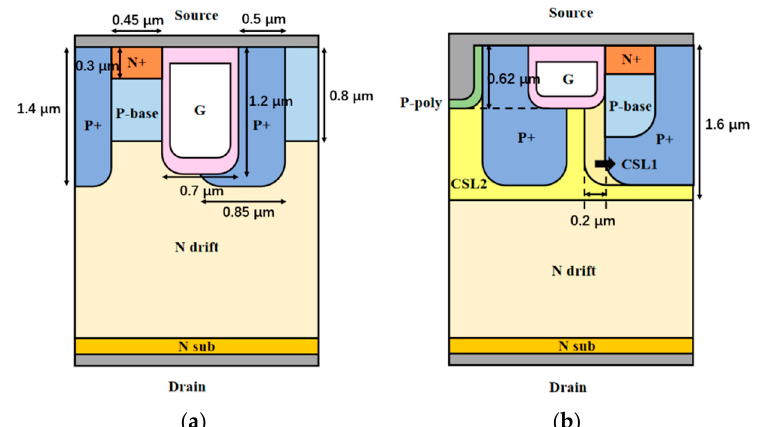
Figure 1. Cross-sectional views of ( a ) C-MOS and ( b ) proposed structure.